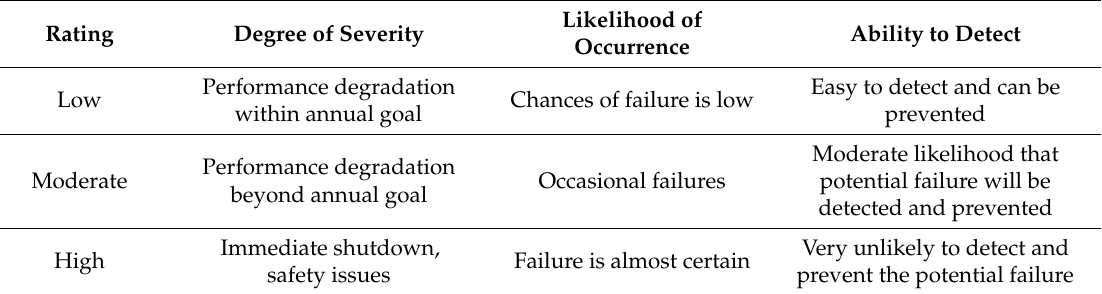
Table 4. Severity, occurrence, and detection rating for SOFC power